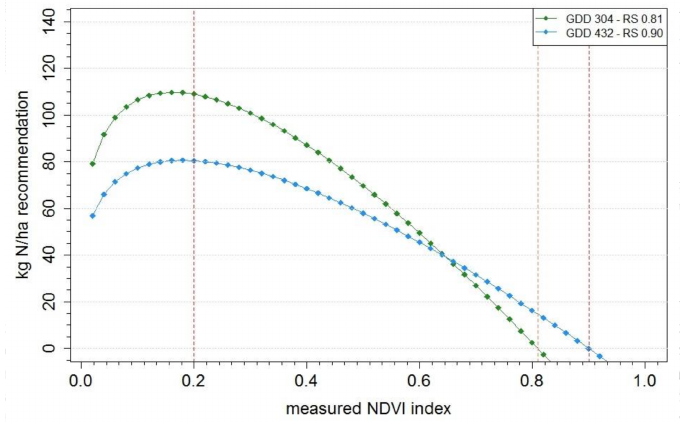
Figure 4. Results of the Valles Altos maize calculation of the NDVI algorithm for growing degree-day sum (GDDsum) 304 and rich strip (RS) NDVI 0.81 from data taken 38 days after planting, and for GDDsum 432 and RS 0.90 from data taken 57 days after planting. Note the cut-off for NDVI